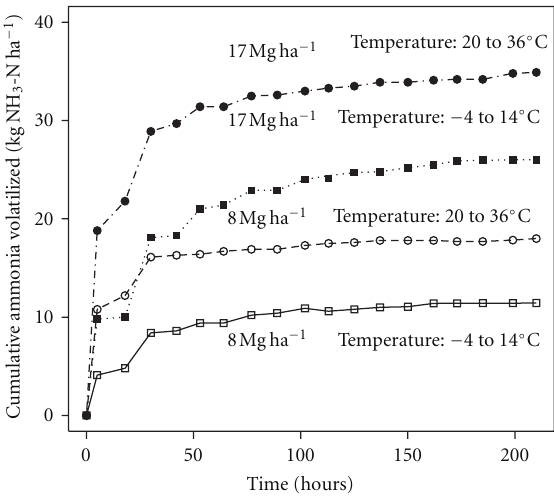
Figure 8: Cumulative ammonia volatilization loss from biosolids under hot conditions (August 1993) and cold conditions (January 1994) from plots treated with 7 or 18 Mgha − 1 of biosolids (adapted from [13]).